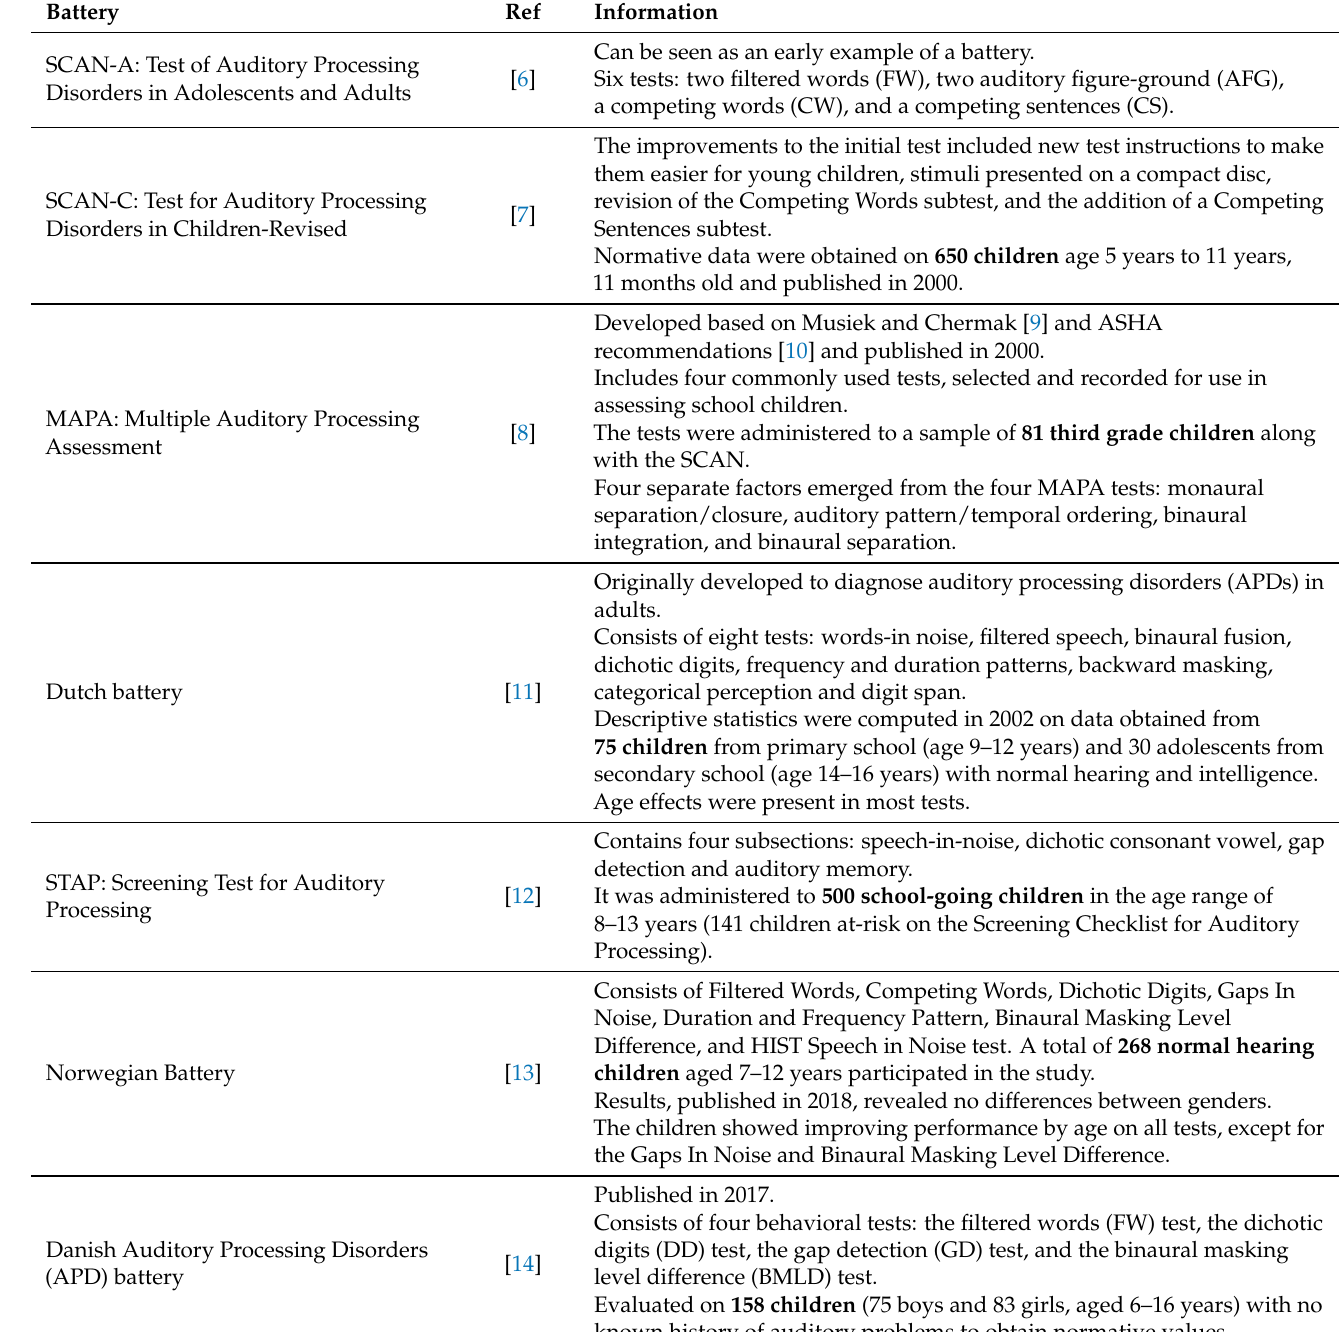
Table 1. A representative small selection of batteries for the evaluation of central auditory processing.